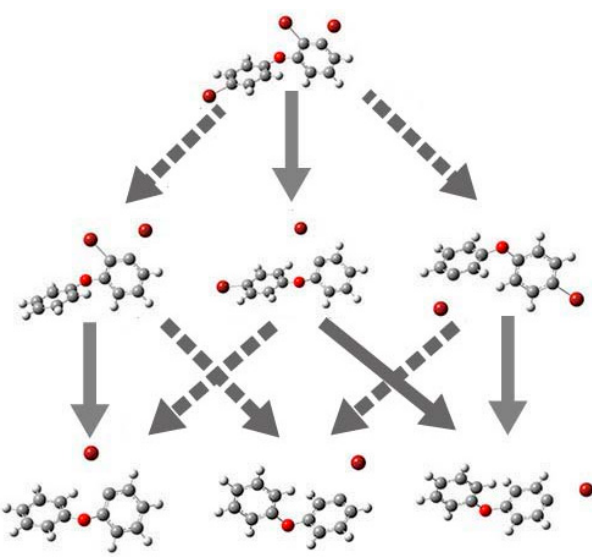
Figure 10. Geometries of the selected anionic BDE congeners optimized at the B3LYP/6-311+G(d) level and the proposed debromination pathway in gas phase (solid arrows indicated major pathways).